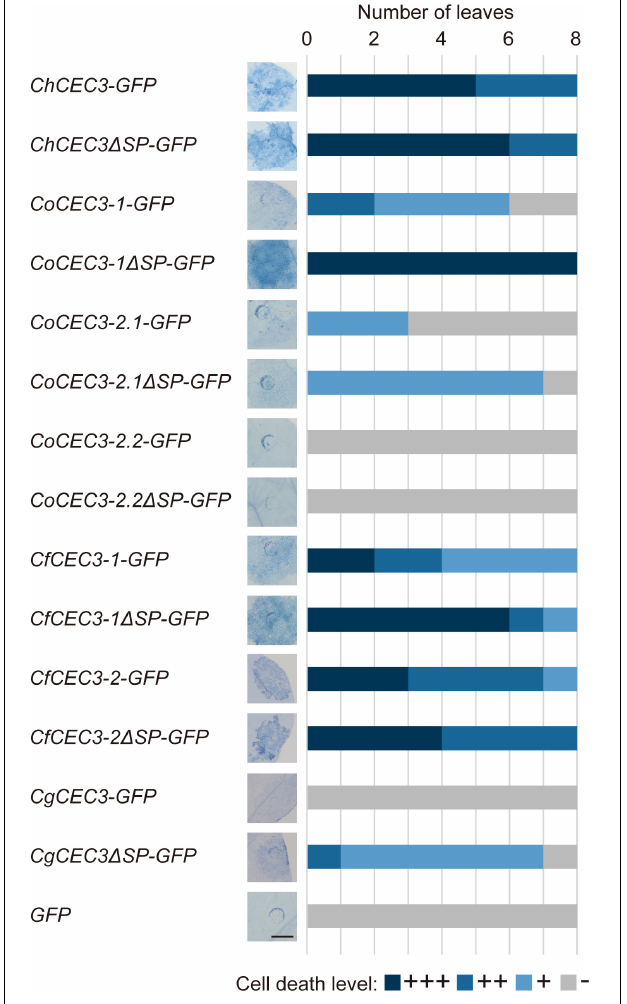
FIGURE 3 | Transient expression of GFP -tagged CEC3 gene-induced cell death in N. benthamiana . N. benthamiana leaves were detached 5 days after infiltration with A. tumefaciens strains carrying GFP -tagged CEC3 genes in binary vectors, and stained with trypan blue to visualize cell death. Stacked bars are color-coded to show the number of each cell death level ( +++ , ++ , + , − ). Cell death induction levels were determined from observation of eight different stained leaves. Representative stained leaf images are shown on the left of the stacked bars. Bar = 5 mm.